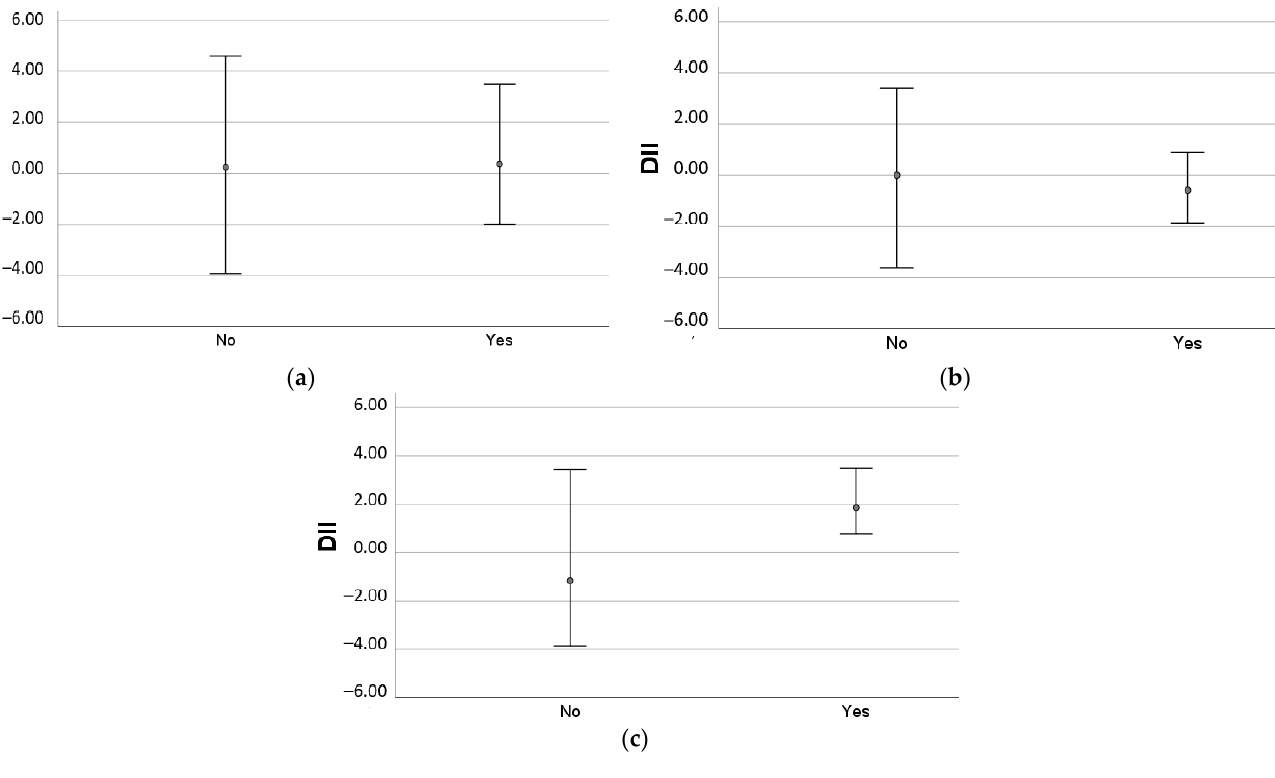
Figure 2. Mean DII based on the presence of advanced fibrosis in MAFLD patients ( a ) without alcohol intake; ( b ) with moderate alcohol intake; ( c ) with harmful alcohol intake.